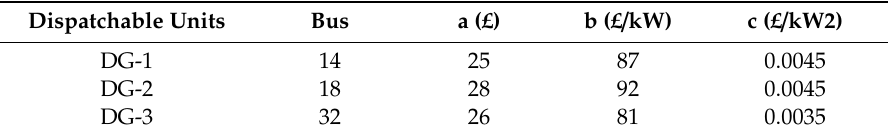
Table 2. Generation of non-dispatchable units (MW)/installed (MW). WT: wind turbine. Time